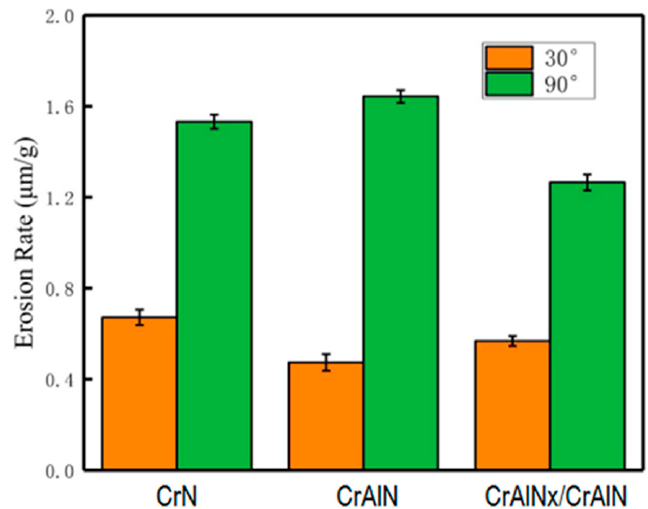
Figure 13. Development of a crack in 10 μ m thick TiN/ZrN multilayer coating deposited on Ti-6Al- 4V alloy using PVD equipment (Pro China Limited AS700DTX, Beijing, China); ( a ) deflection of a crack (marked by letter F), ( b ) branching of a crack (marked by letter G), reprinted from Coatings , Reference [111], published in MDPI. Figure 14. Erosion rate of 2.24 μ m thick CrN, 1.92 μ m thick CrAlN and 2.17 μ m thick CrAlNx/CrAlN coatings deposited on TC11 titanium alloy using the arc ion plating technique, reprinted from Vacuum , Reference [9], with permission from Elsevier.